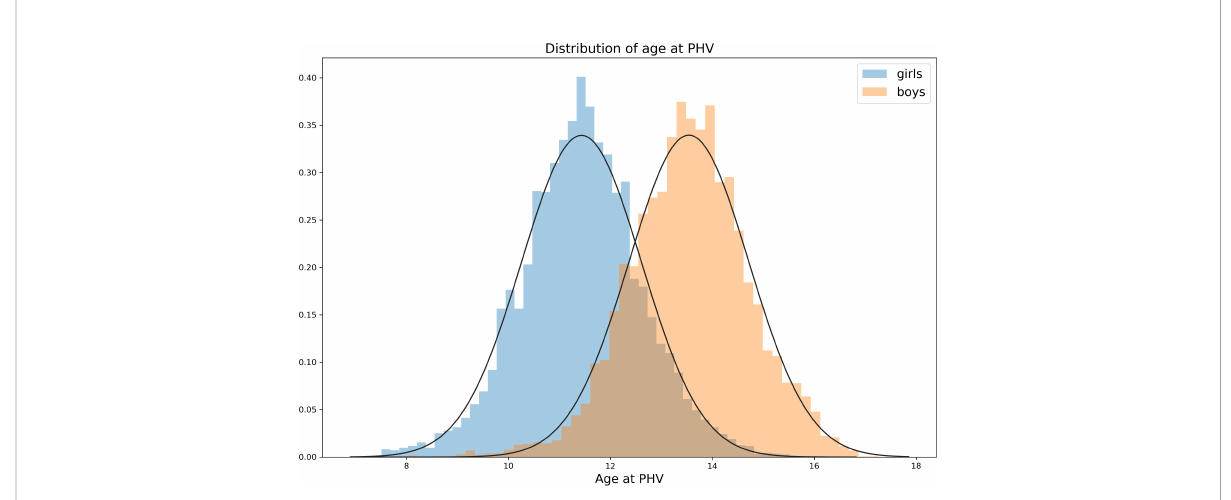
FIGURE 2 Distribution of age at PHV determined with 7th degree polynomial function for girls (n=6392) and boys (n=6893). The mean age at PHV for girls was 11.43 years ( ± 1.18 SD) and for boys 13.54 years ( ± 1.17